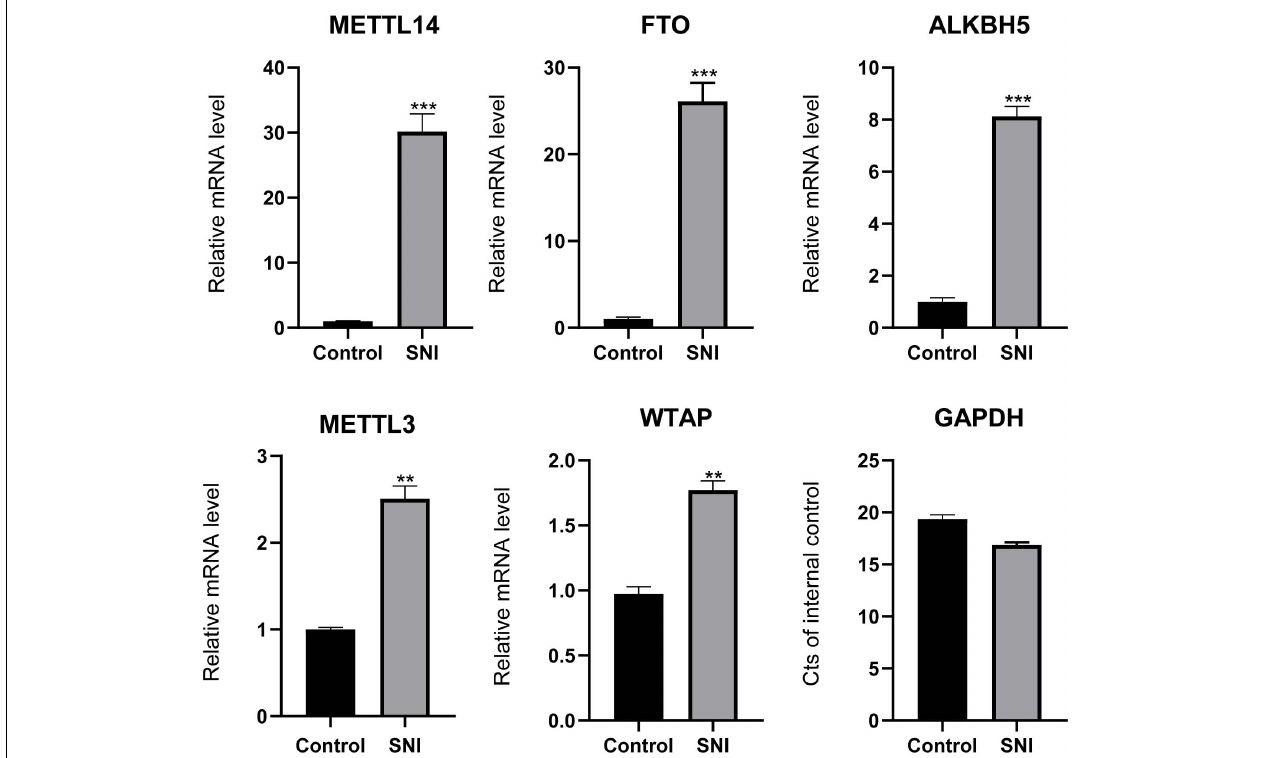
FIGURE 1 | The expression levels of writers and erasers. Quantitative RT-PCR showing the upregulated levels of METTL3, METTL14, WTAP, FTO, and ALKBH5. Among them, the expression levels of METTL14 and FTO were the most significant. GAPDH was used as an internal control. SNI group ( n = 3); control group ( n = 3). “**” and “***” indicate p < 0.01 and p < 0.001, respectively, via Student’s t test.